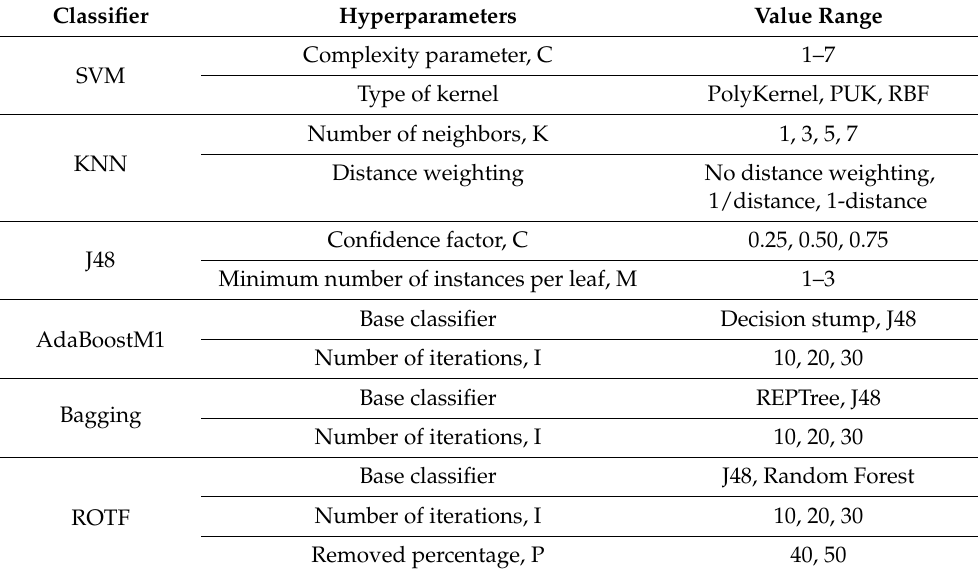
Table 5. Hyperparameters and their value range of machine learning